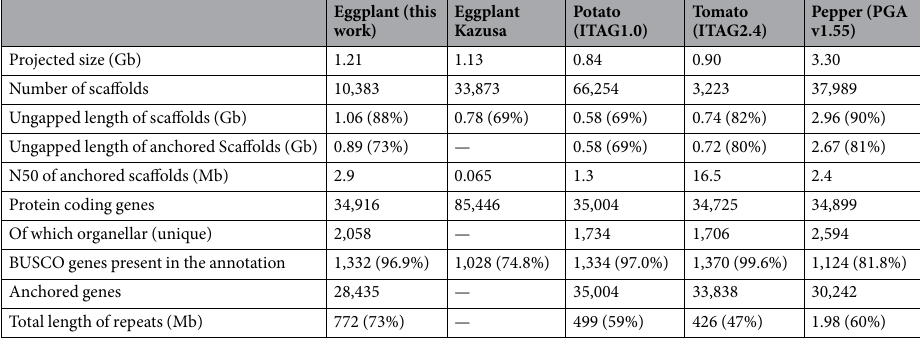
Table 1. Assembly and annotation metrics of the eggplant genome and its comparison with other high-quality Solanaceae genomes and the previous eggplant